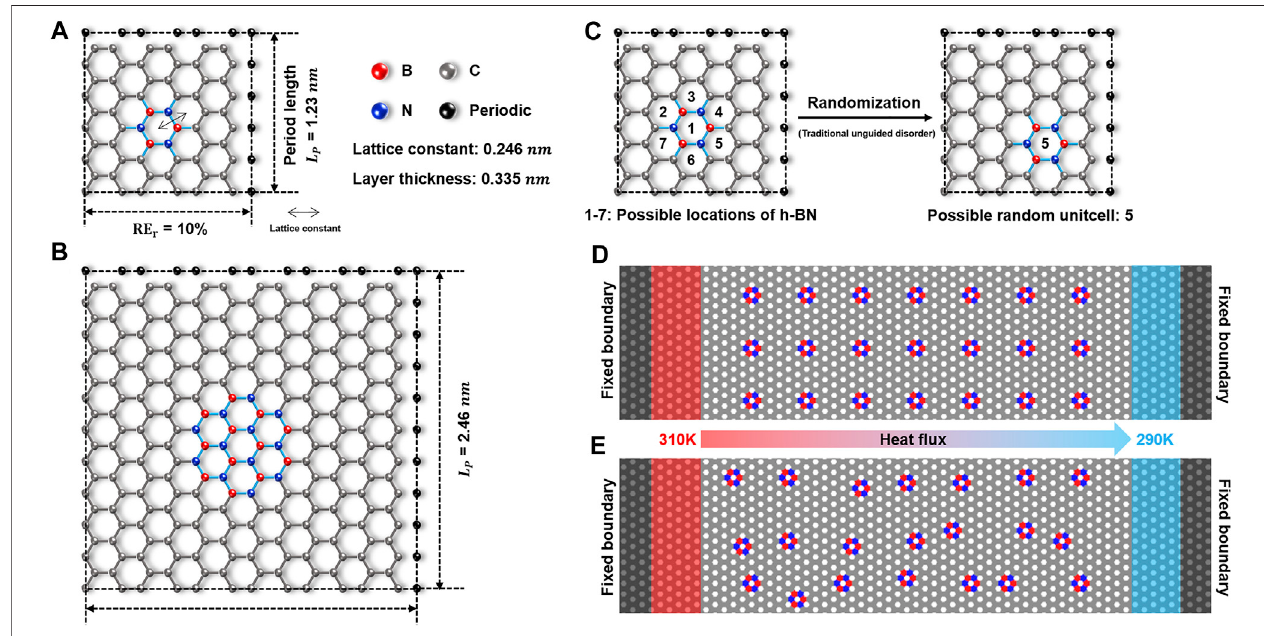
FIGURE1| Schematic fi guresofG/ h -BNlateralheterostructure. (A) – (B) Schematicdiagramsoftheunitcellswith L p (cid:1) 1 . 23 nm and2 . 46 nm .Thereplacementrate is fi xed at 10%. (C) Schematic diagram of the introduction of disorder. (D) – (E) Schematic diagram of periodic structure and TU-DS.